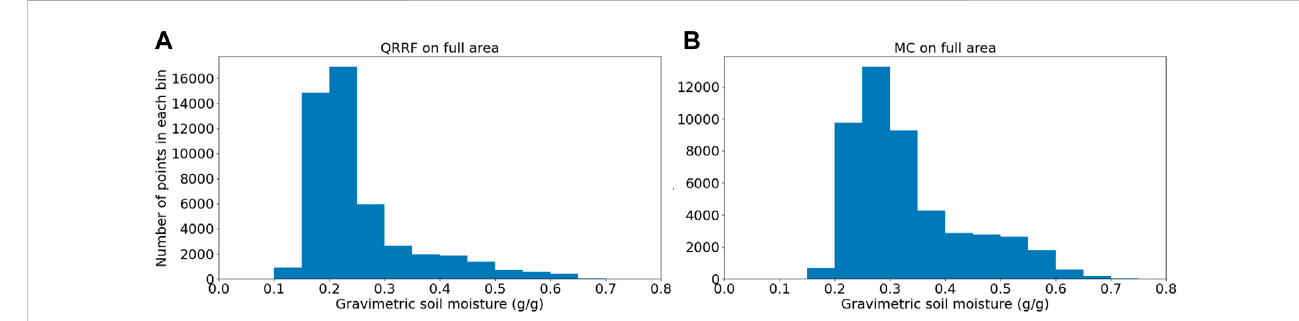
FIGURE 13 Histograms displaying the distribution of the predicted soil moisture values on the full area for the QRRF prediction (A) and the MC after 1,000 iterations (B) .